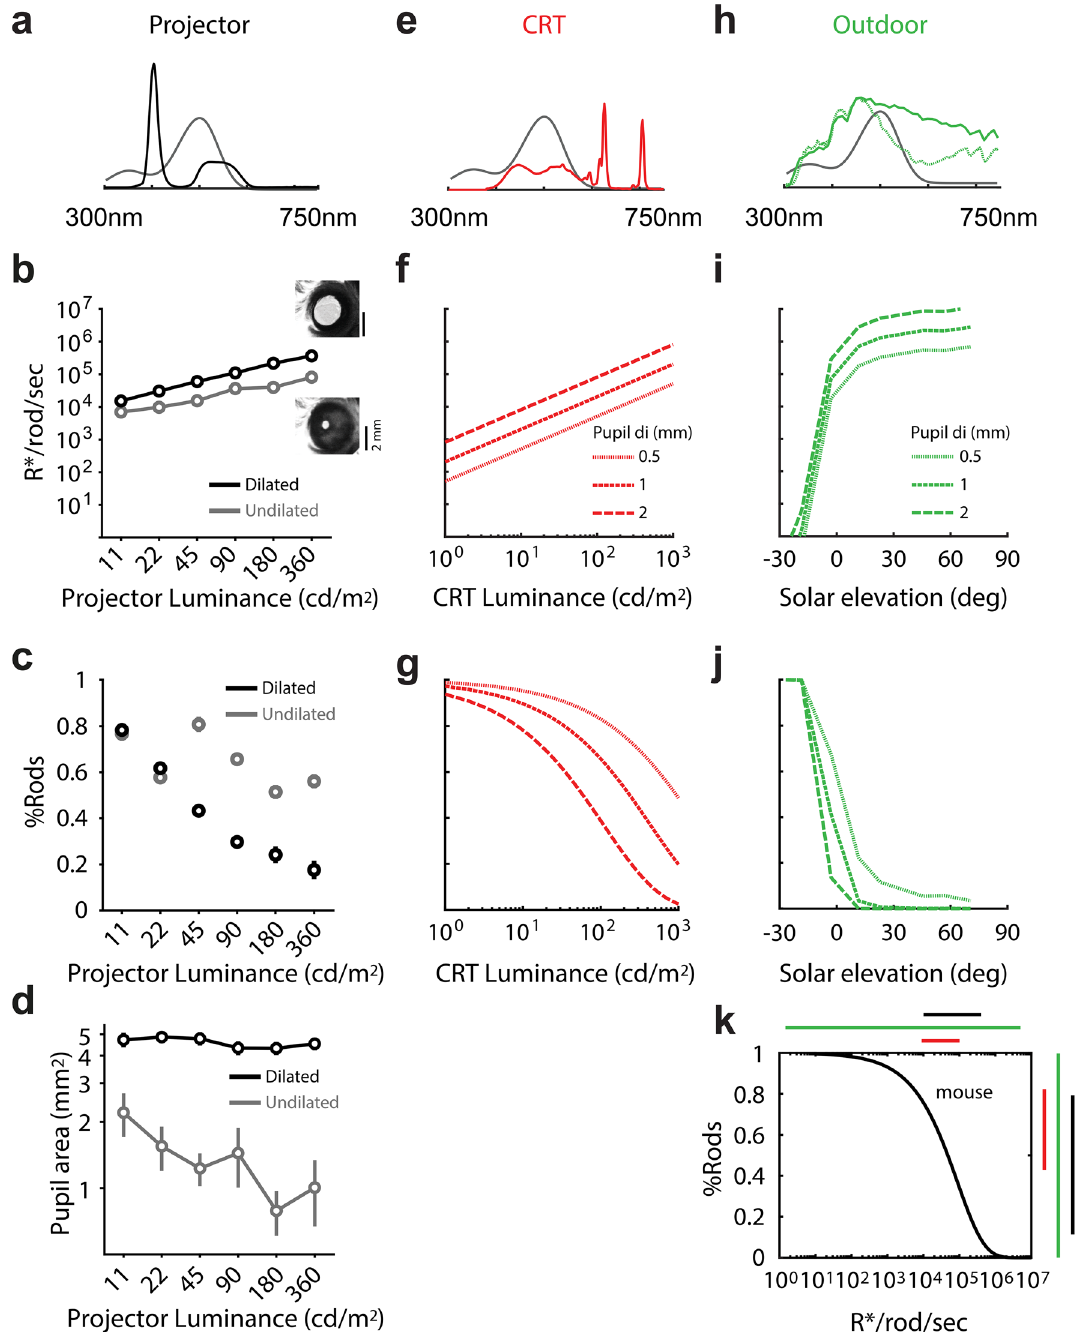
Figure 4. Variable states of retinal adaptation via pupil size, background light level, and stimulus source. ( a ) In black is the spectrum of the projector used in this study, with both green and nUV LEDs ‘”on”. ( b ) Rod isomerization rates measured at variable projector background light level, with and without application of tropicamide. To begin, the 6 adaptation blocks were shown, in ascending order (b1-to-b6), to an undilated (naive) pupil. Next, the pupil was dilated using tropicamide and reshown the 6 stimulus adaptation blocks in descending order (b6-to-b1). ( c ) %Rod input to V1 as a function of projector luminance values, for undilated and dilated pupils. ( d ) Mean and standard error of pupil area at 6 light levels (x-axis) with and without application of tropicamide. ( e ) In red is the spectral power distribution of a CRT with RGB guns all “on”. (f) Model of mouse rod isomerization rates over a wide range of CRT intensity, in cd/ m 2 . ( g ) Prediction of %Rod contribution to V1 as a function of CRT luminance values. ( h ) In solid green is the power distribution of the CIE D65 standard, used as the daylight spectrum. The dashed green line is the spectrum used after sunset. Absolute daylight irradiance values were obtained from Spitschan et al. 8 ( i ) Model of rod isomerization rates at varying solar elevation in an urban setting. ( j ) Prediction of %Rod contribution as a function of solar elevation. Positive and negative is above and below the horizon, respectively. ( k ) In black is the model fit of %Rod contribution vs. rod isomerization rates. It was used to transform the plots in ‘f’ and ‘i’ into the plots in ‘g’ and ‘j’. The color bars on top approximate the range of rod isomerization rates generated by each stimulus source. Similarly, the y-axis shows the ability of each source to push the rodent retina into a photopic (i.e. %Rod = 0) vs. scotopic (i.e. %Rod = 1)